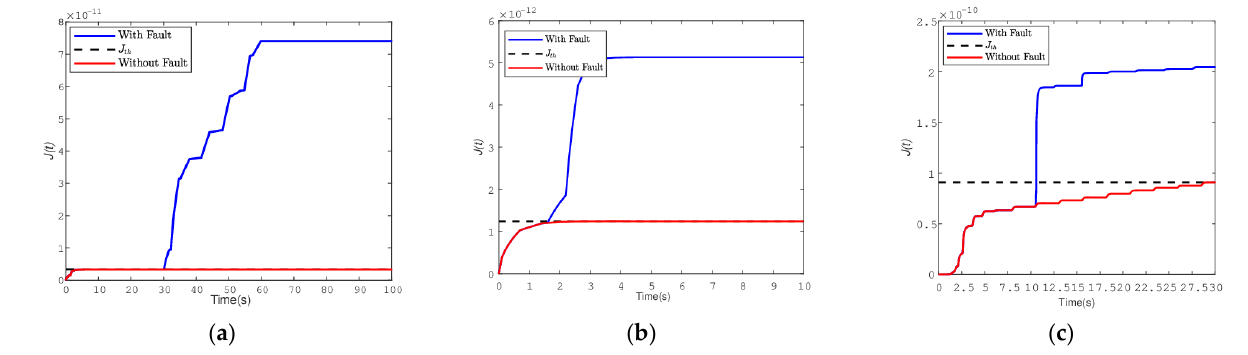
pendulum on a cart. It readjusts that the experimental time is 30 s and sampling period